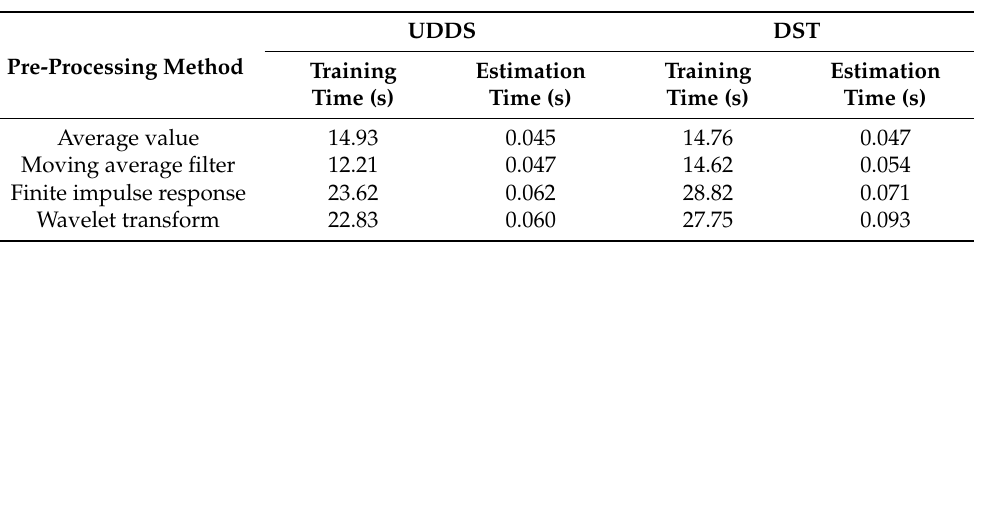
Table 7. Computational time of different pre-processing